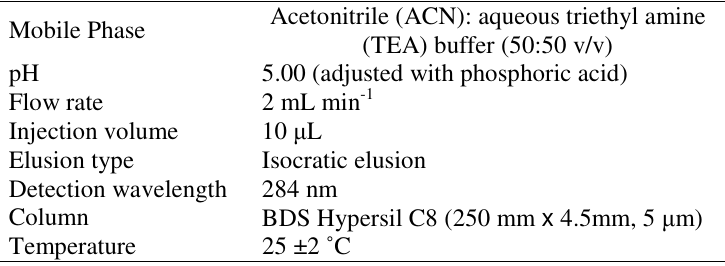
Table 1. Chromatographic